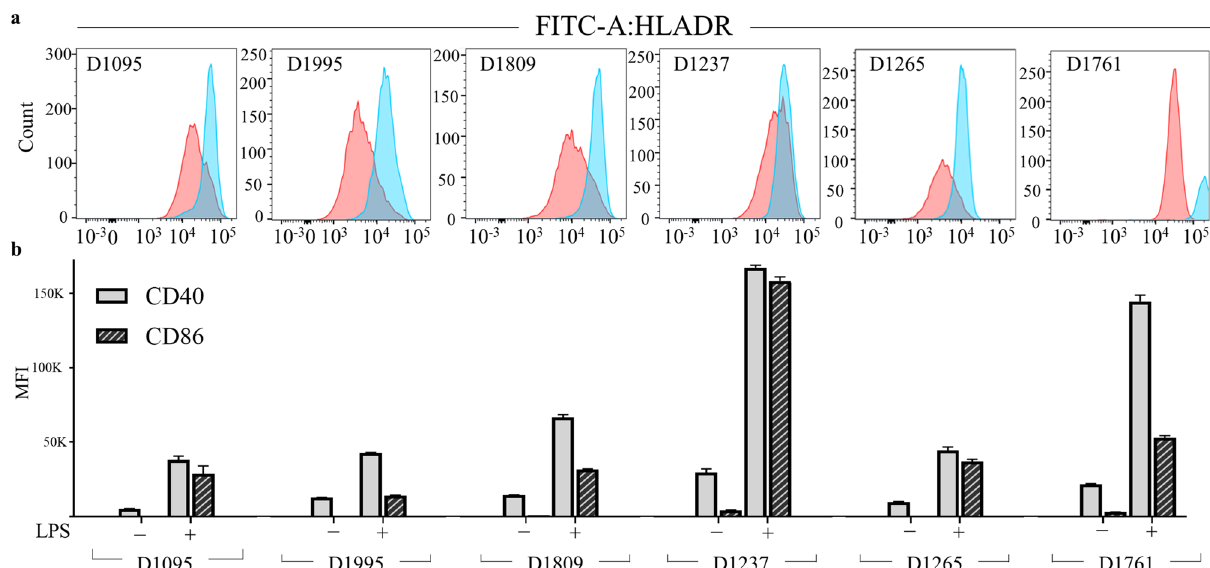
Figure 2. Increase of HLA-DR, CD40 and CD86 at the plasma membrane confirms DC activation upon LPS treatment. ( a ) csHLA-DR detection by flow cytometry in donor-derived monocytic DCs activated with LPS (blue) in comparison with unstimulated DCs (red), D1761 singlet analysis not available. ( b ) Activation markers CD40 (gray bars) and CD86 (striped bars) in 6 sets of donors presented as median fluorescence intensity (MFI) of APC and PE, respectively, each bar represents the mean and the SD. Statistical differences between unstimulated and LPS-treated in three replicates from ( a ) and ( b ) were evaluated with a two-tailed Student’s t Test ( p < 0.05 and p < 0.001,